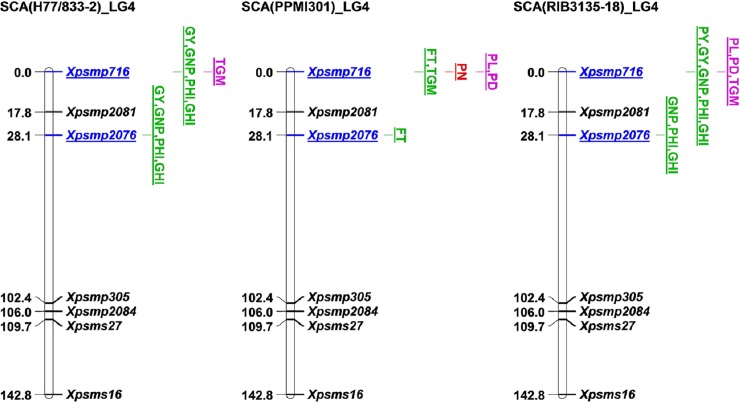
Linkage map of pearl millet LG4 showing significant SCA loci with LOD > 5.0 and at p<0.001 with three testers a) H77/833-2; b) PPMI301;c) RIB3135-18. Significant SCA loci associated with traits in control (CN) (blue color), moisture stress (MS) (red color), across moisture regimes (AMR) (green color), CN+MS (pink color), CN+AMR (purple color) and CN+MS+AMR (brown color) Note: FT-flowering time, PL- Panicle length, PD- Panicle diameter, PN- Panicle number, PY- Panicle yield, GY- Grain yield, TGM- 1000-grain mass, GNP- grain number per panicle, PHI- Panicle harvest index; GHI- grain harvest index.